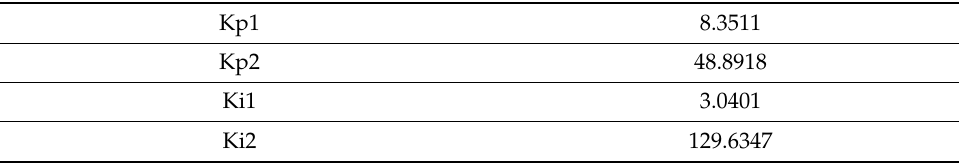
Table 1. Optimal values of PI